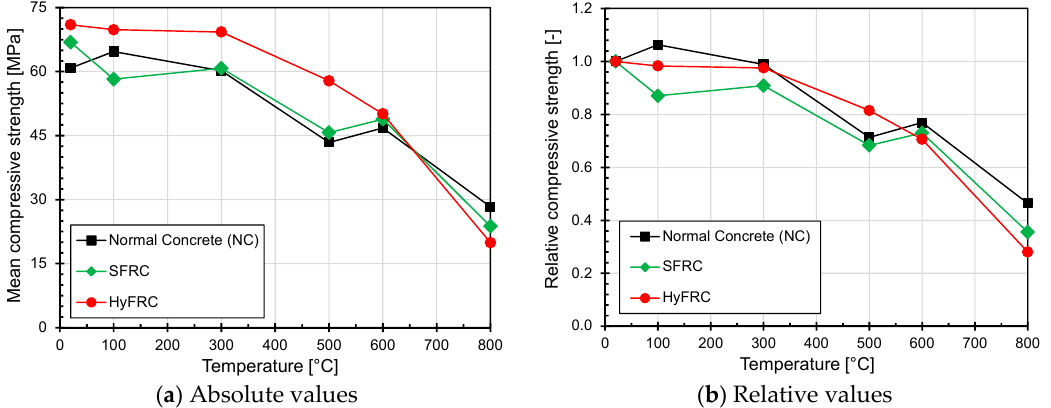
Figure 4. Influence of elevated temperature on compressive strength of different types of concrete.